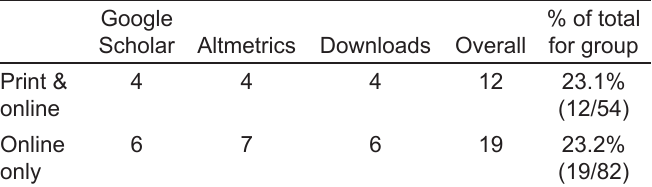
Table 2. Performance of those Western Journal of Emergency Medicine Special Issue published articles selected for print version in addition to online publication vs those published online only from 2015-2019.